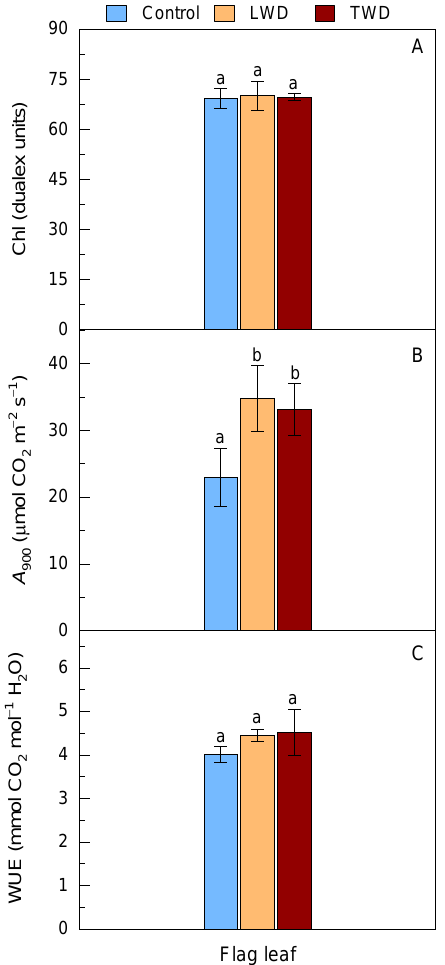
Figure 3. Effect of two water deficit treatments under combined elevated CO 2 and high temperature on chlorophyll (Chl) (Panel A ), leaf net CO 2 assimilation rate ( A ) (Panel B ) and water use efficiency (WUE) (Panel C ) of the flag leaves of potted wheat plants. Leaf gas exchange was measured at 900 ppm of CO 2 . Legend is as described in Figure 2. Bars represent mean values ± SD. Different letters above the bars (a and b) indicate statistically significant differences among treatments for each organ after post-hoc test analyses ( p -value ≤ 0.05, n = 4, see Spreadsheet S1,